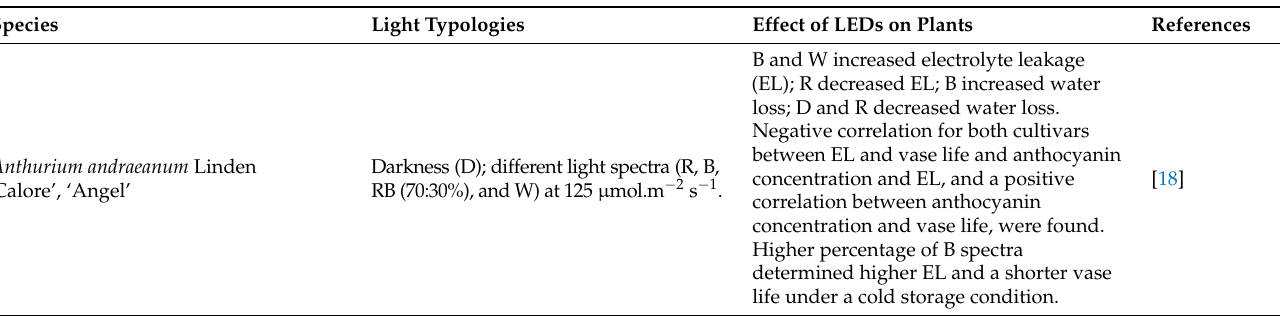
Table 1. Main effects of LEDs on different ornamental plants. Species Light Typologies Effect of LEDs on